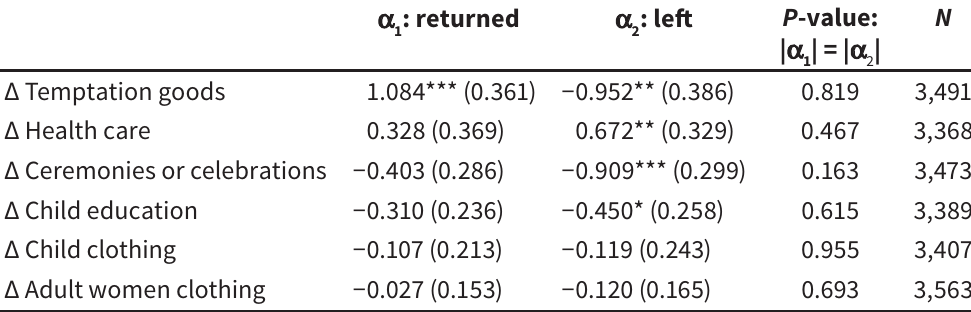
Dynamic shifts in expenditures: first-difference approach ( asinh )